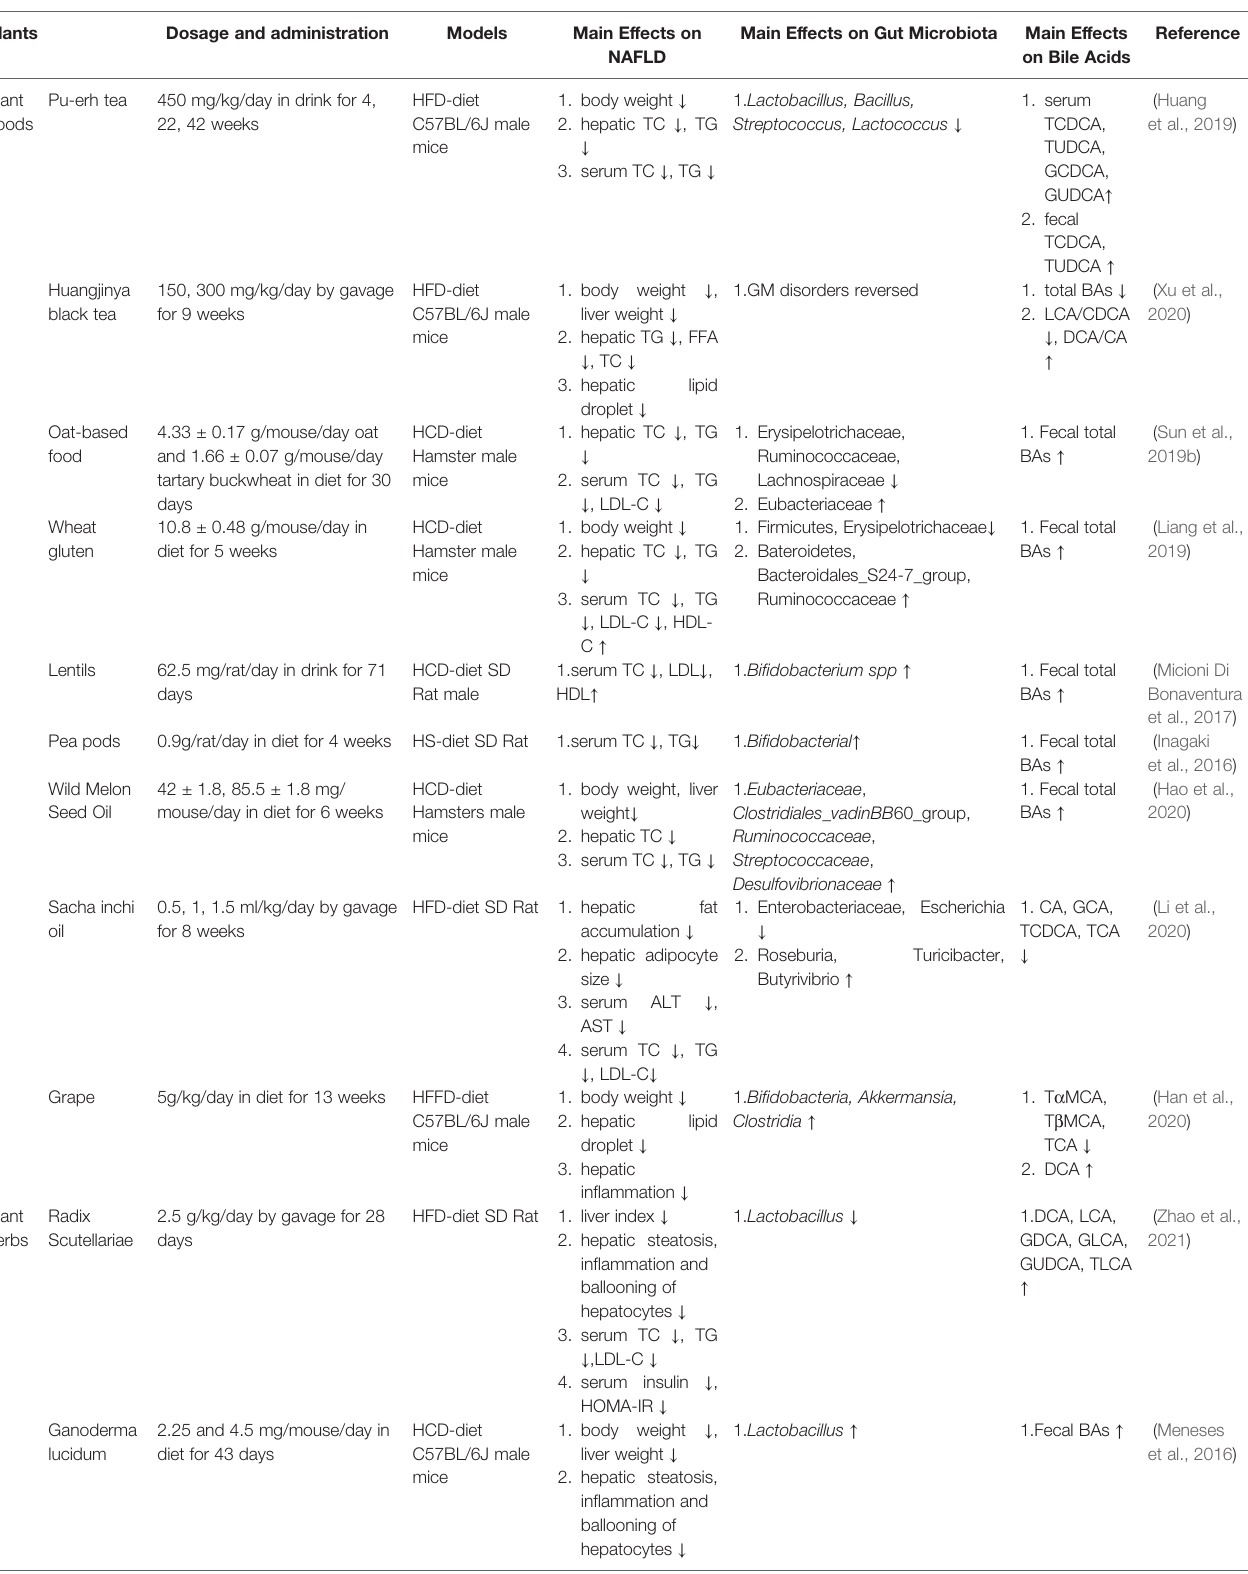
TABLE 1 | Natural plants regulate the interplay between GM and BAs in the treatment of NAFLD.